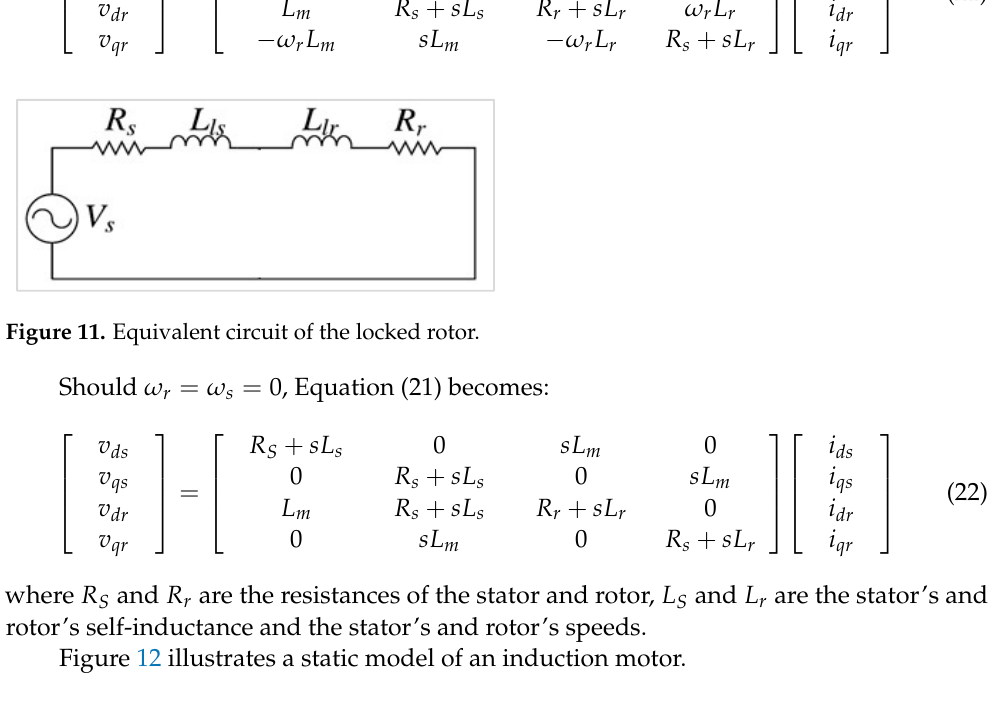
Figure 12. A static model of an induction motor.